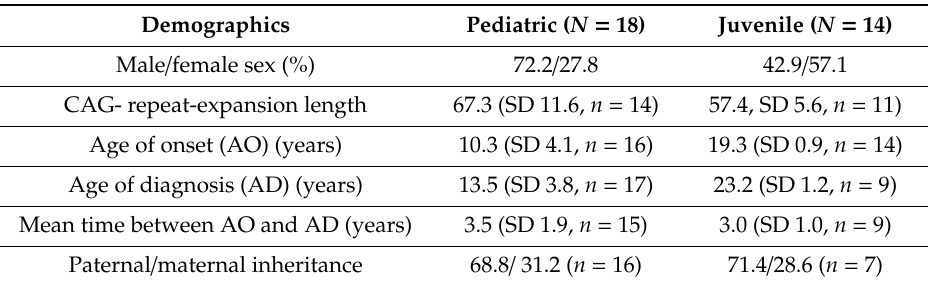
Table 2. Demographics of the pediatric and juvenile HD